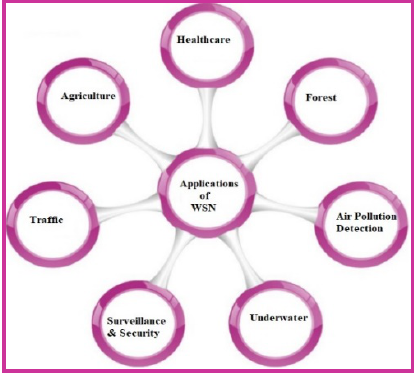
Figure 1. Applications of Wireless Sensor Networks